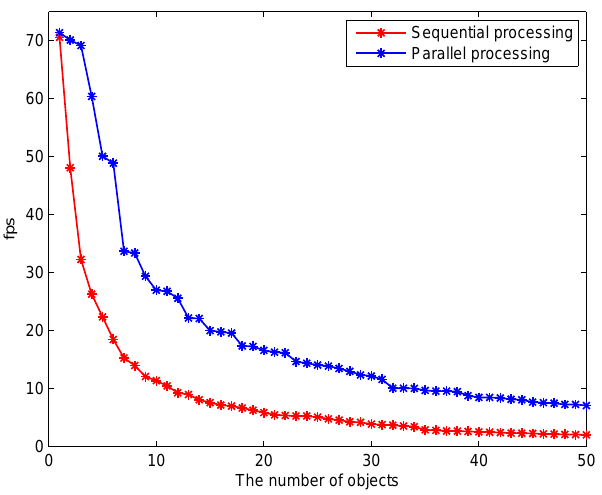
Figure 16. Processing speed comparison (tracker). This figure shows the relationship between the processing speed and the total number of objects (sequential and parallel processing).